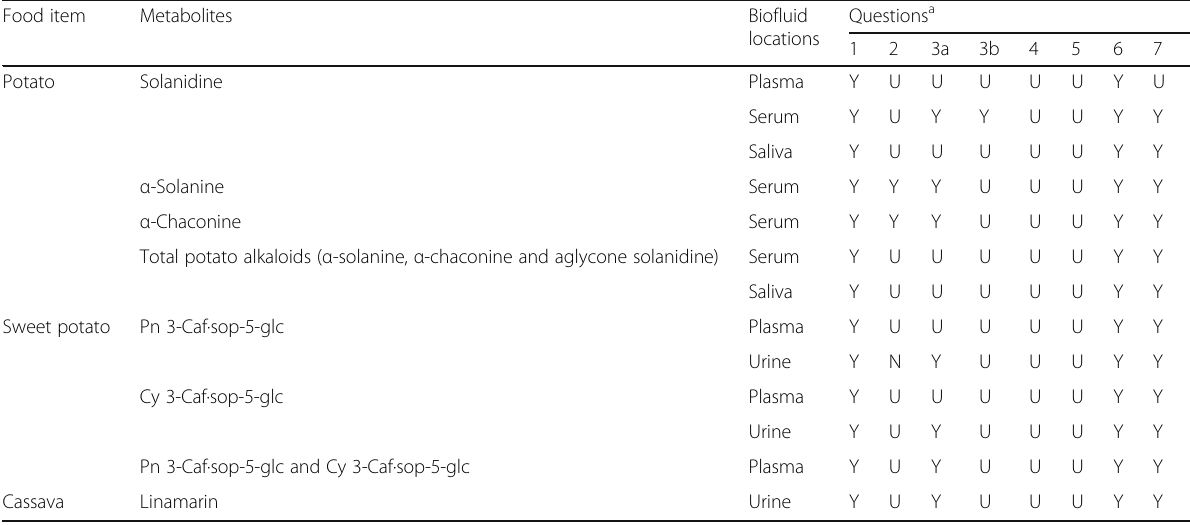
Table 4 Validation scoring scheme for candidate tuber intake biomarkers Food